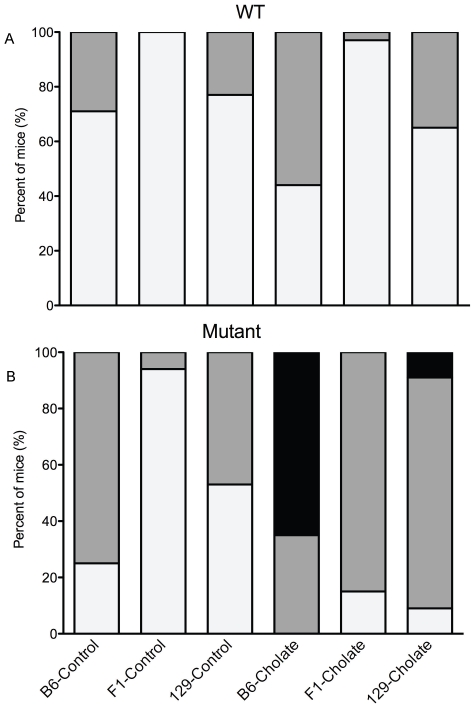
Serum bilirubin concentration increases in ATP8B1 mutant mice upon cholate feeding.Proportion of WT (A) and ATP8B1 mutant (B) mice of B6, 129, and F1 backgrounds with normal (light grey), moderately elevated (medium grey), and highly elevated (black) serum bilirubin levels in after feeding cholate or control diet for 4–8 days. N's for cholate diet: B6 (n = 5−8), 129 (n = 30−31), and F1 (n = 13−25); and control diet: B6 (n = 10−13), 129 (n = 39−48), and F1 (n = 18−23).